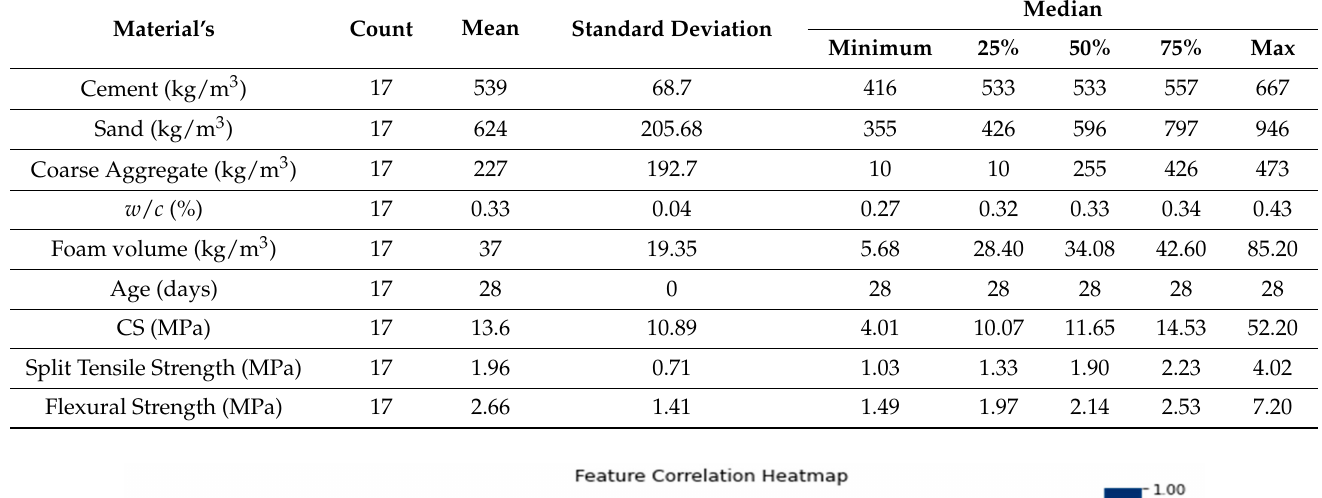
Table 7. Exploratory Data Analysis of Different Mix Proportions and their Strengths.